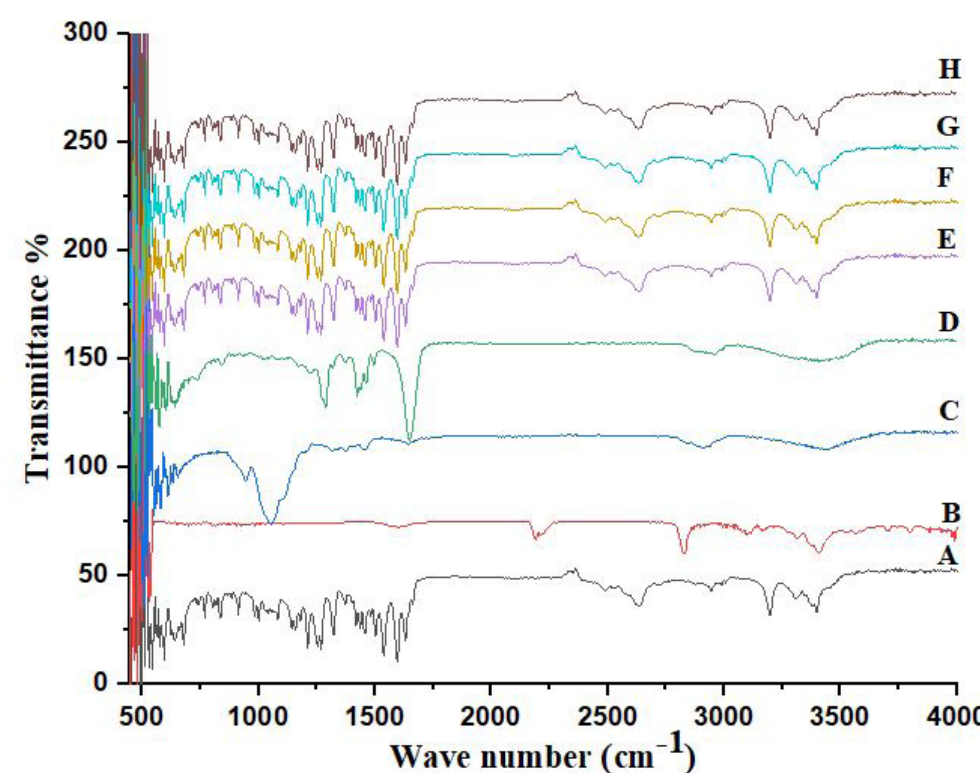
FIGURE 2 - FTIR spectra of Metoclopramide (A), Eudragit L100 (B), Methylcellulose (C), Polyvinylpyrrolidone K30 (D), formulations Z4 (E), Z9 (F), Z4-O2 (G) and Z4-E2